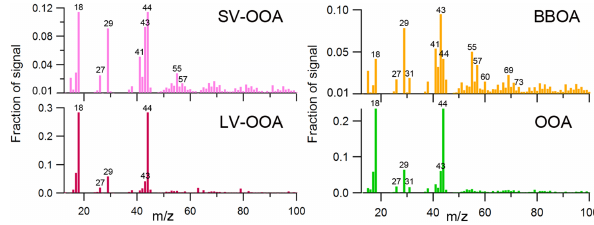
Fig. 8. OA mass spectra of (a) SV-OOA and LV-OOA (wet season) and (b) BBOA and OOA (dry